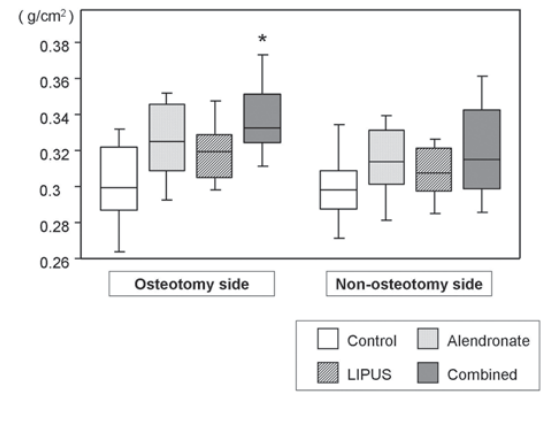
Figure 2: Control = Saline vehicle + Sham-LIPUS; Alendronate = Alendronate + sham-LIPUS; LIPUS = Saline vehicle + LIPUS; Combined = Alendronate + LIPUS. * p < 0.001 calculated in multiple comparison using Scheffe’s post-hoc